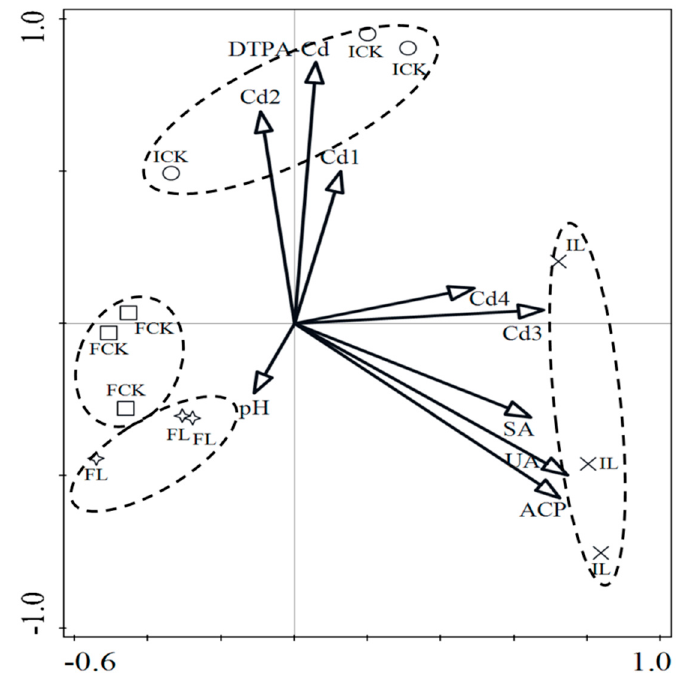
Figure 4. Redundancy analysis (RDA) of the correlation of environmental parameters and bacterial species based on different treatments. DTPA-Cd stands for soil available Cd. Environmental variables were represented as arrows. The length of the arrows manifested the relative importance of that environmental factor in explaining the variation of bacteria and community structures, while the angles between the arrows reflected the degree of the correlations.